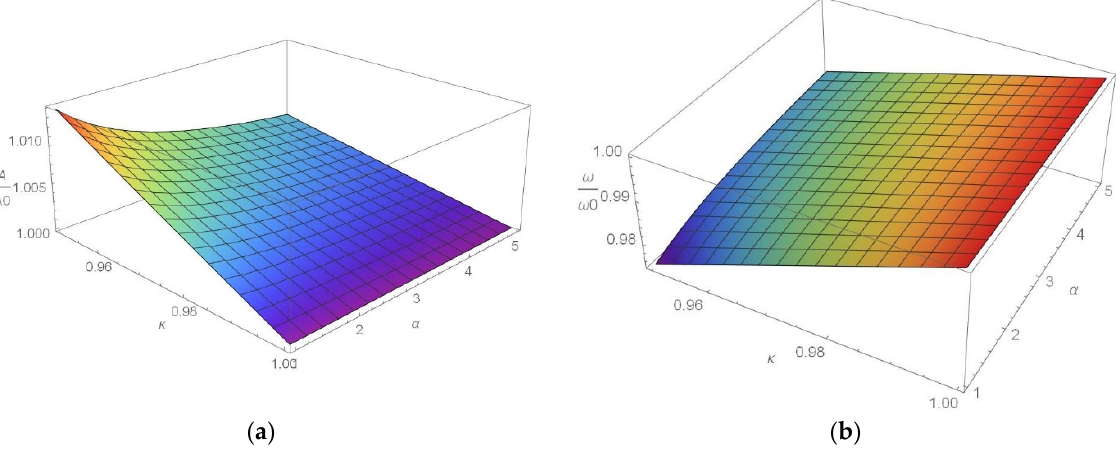
Figure 7. ( a ) A/A 0 - α - κ and ( b ) ω / ω 0 - α - κ diagrams. Figure 7. ( a ) A / A 0 - α - κ and ( b ) ω / ω 0 - α - κ diagrams.